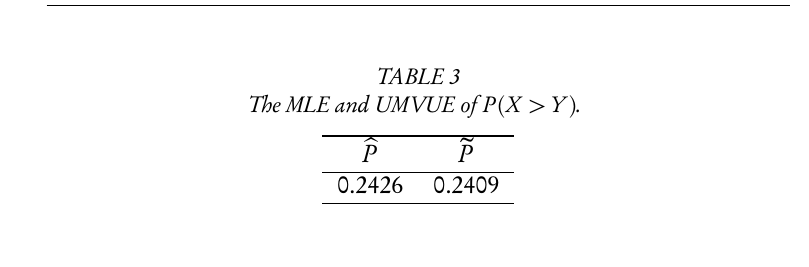
and θ of Weibull distribution and its 2 2